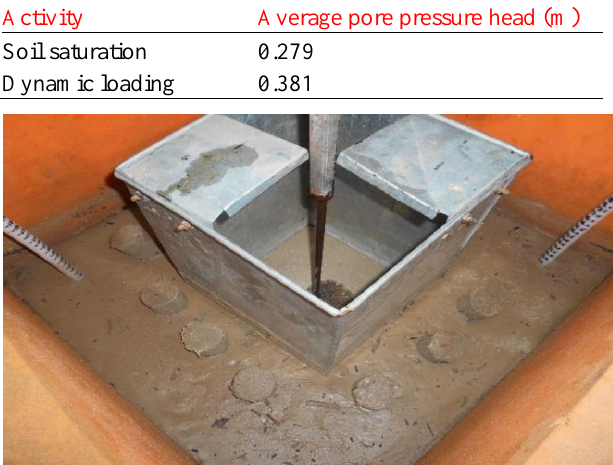
Average Pore Pressure Heads in Treated 1-g Physical Model- I with Treatment Adjacent to Structure